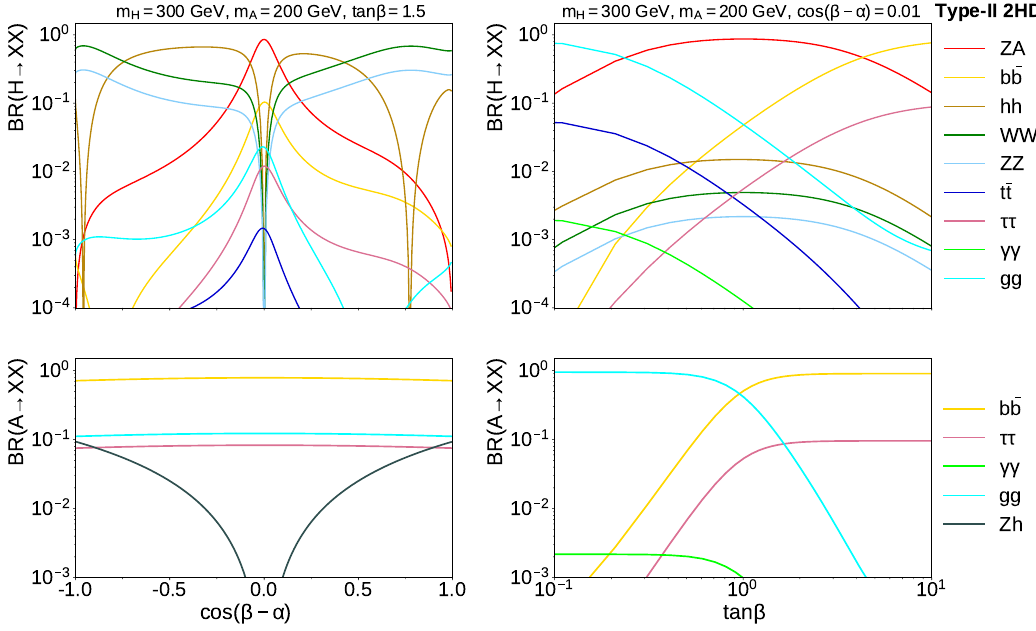
Figure 2 . The H and A branching fractions as a function of cos( (cid:12) (cid:0) (cid:11) ) in Type-II 2HDM for the following set of parameters: tan (cid:12) = 1 : 5, m = 300 GeV, m = 200 GeV (left). The H and H A A branching fractions as a function of tan (cid:12) in Type-II 2HDM for the following set of parameters: cos( (cid:12) (cid:0) (cid:11) ) = 0 : 01, m = 300 GeV and m = 200 GeV (right). H A